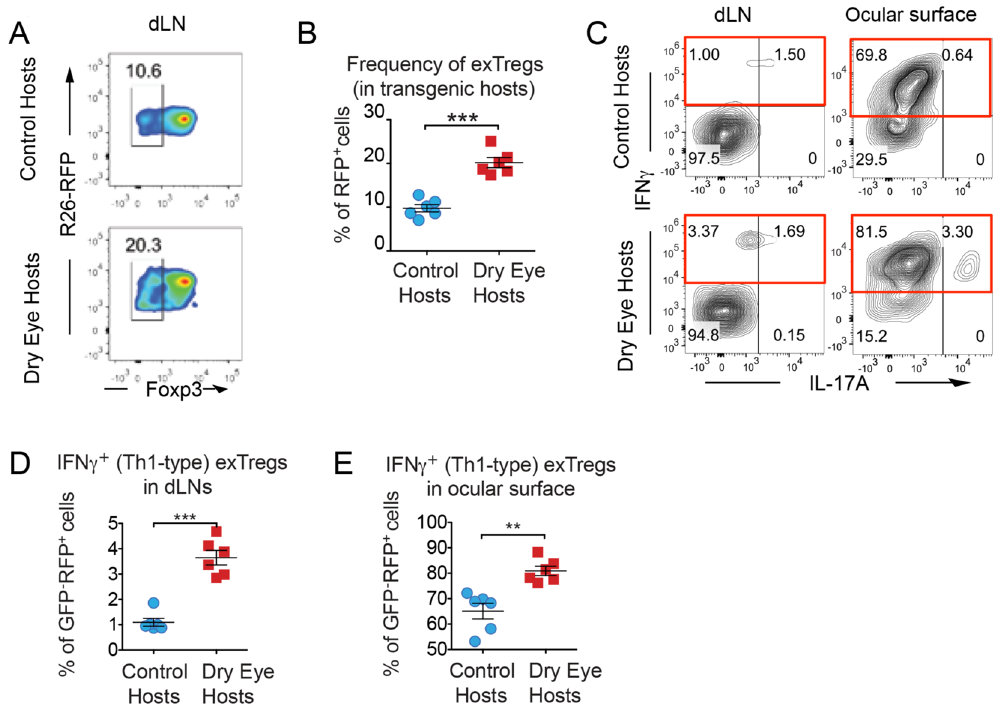
Figure 2. Dry eye disease promotes loss of Foxp3 expression by Tregs following corneal transplantation. Foxp3- GFP-CreXR26-RFP transgenic mice were used to trace Foxp3 expression after transplantation. Healthy corneal grafts were transplanted onto transgenic naïve control hosts or dry eye (DED) hosts. Draining lymph nodes were harvested 2 weeks post-transplantation. Single cell suspensions were analyzed by flow cytometry. ( A ) Representative flow cytometry plots and ( B ) statistical analysis of flow cytometry data showing frequencies of exFoxp3 cells in Foxp3-GFPXR26-RFP control and DED hosts (n = 6/group, *** p < 0.001). ( C ) Representative flow cytometry plots and ( D, E ) statistical analyses of flow cytometry data showing frequencies of exFoxp3 cells that express IFN γ ( *** p < 0.001) and IL-17 ( ** p < 0.01) in Foxp3-GFPXR26-RFP control and DED hosts (n = 6/group). Data is presented as mean ± SEM (error